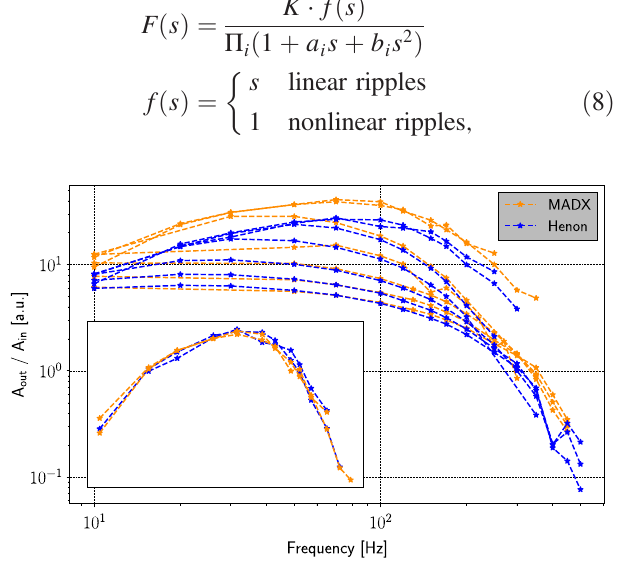
FIG. 8. Fixed ripple amplitude transfer functions obtained for the Henon map simulation and for the full strength-to-spill MADX model (respectively reported in Figs. 7 and 2). The small plot shows the full compatibility between the Henon and MADX small- amplitudes transfer function after rescaling the Henon one by a